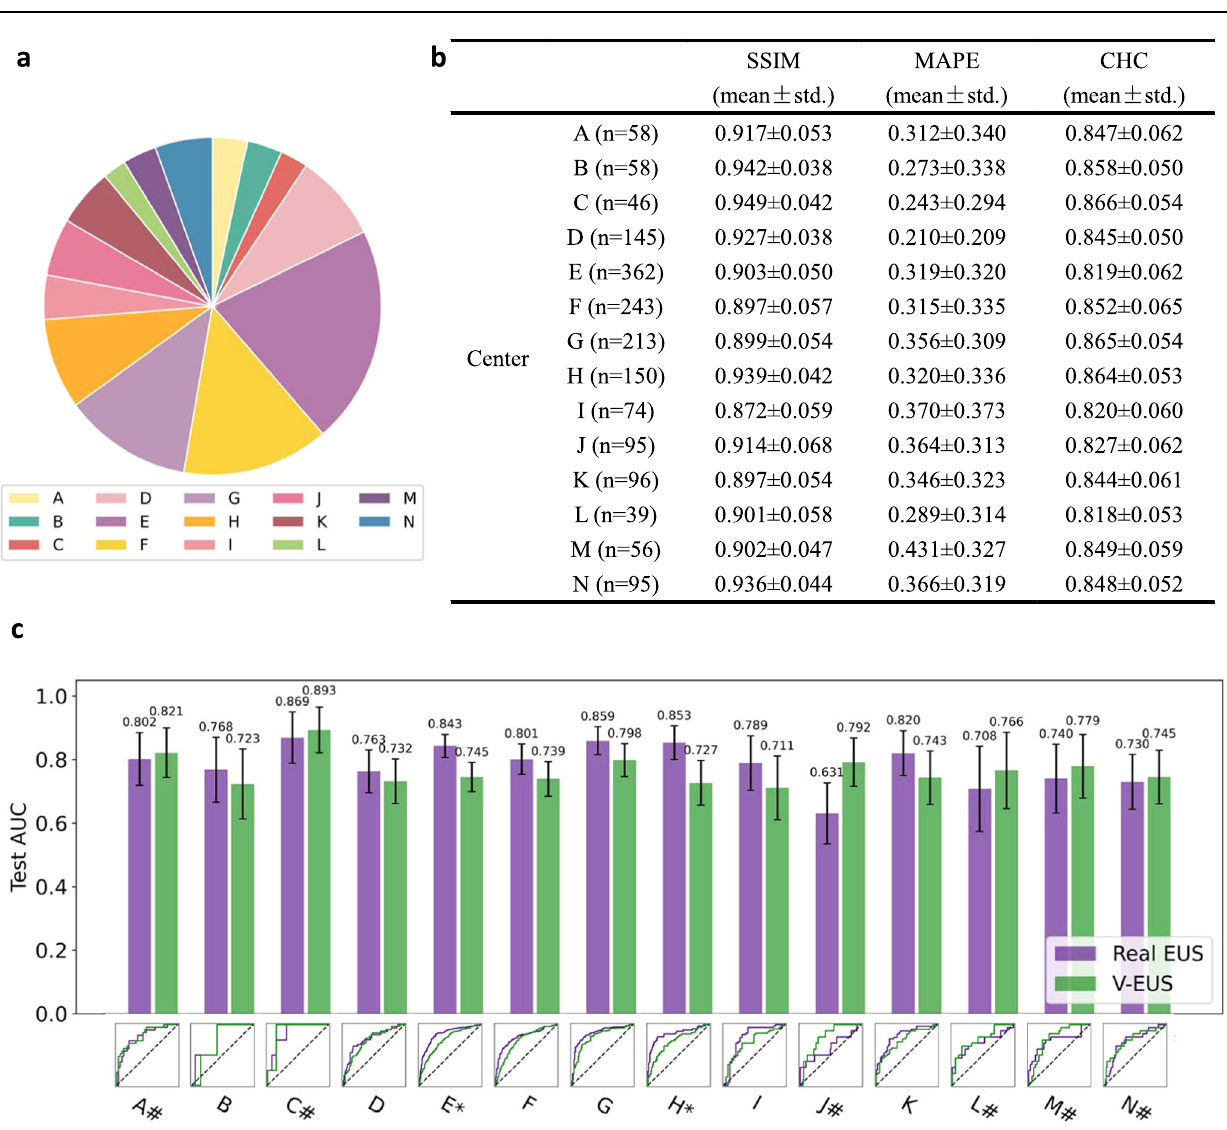
Fig.3|Adaptabilitytoexternalmulti-centerexternaltestcohorts.a Numberof cases comparison of multi-center external test cohort. b SSIM, MAPE and CHC comparison in all 14 medical center data. c ROC comparison of 14 medical center. *indicates a signi fi cant difference ( p <0.05, the p -value for the center E is 0.0005